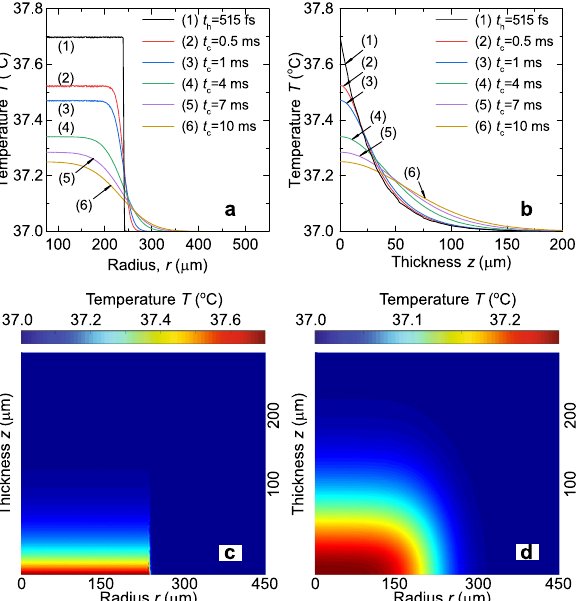
0 ) and ( b ) axial (at = 10 ms for = [ ]